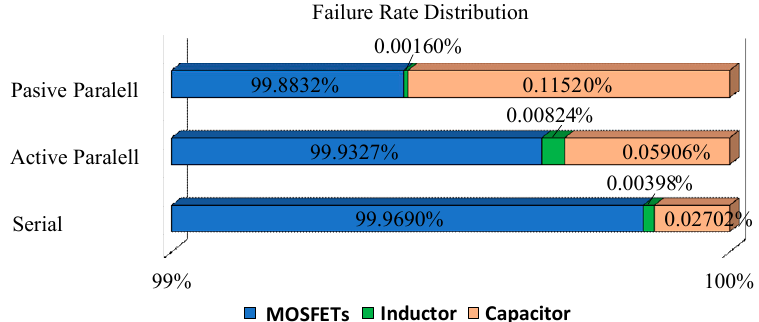
Figure 7. Reliability comparison of the di ff erent structures.